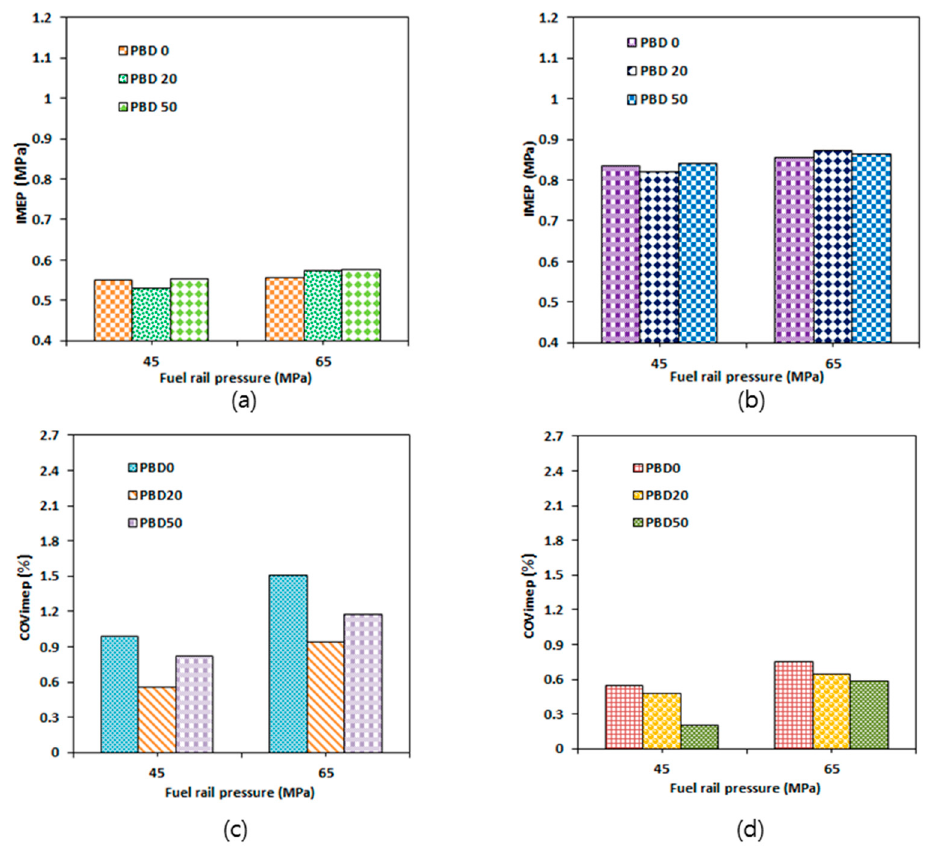
Figure 5. IMEP for engine loads of ( a ) 50 Nm and ( b ) 100 Nm. COV IMEP for engine loads of ( c ) 50 Nm and ( d ) 100 Nm. 250